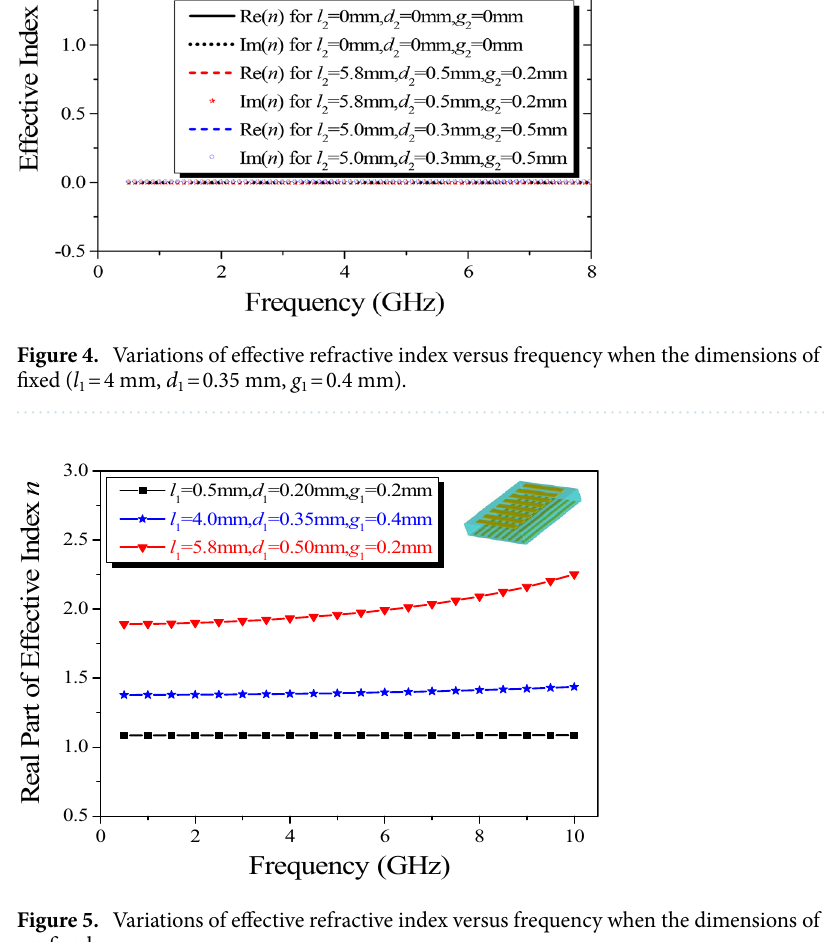
Figure 5. Variations of effective refractive index versus frequency when the dimensions of the bottom structure are